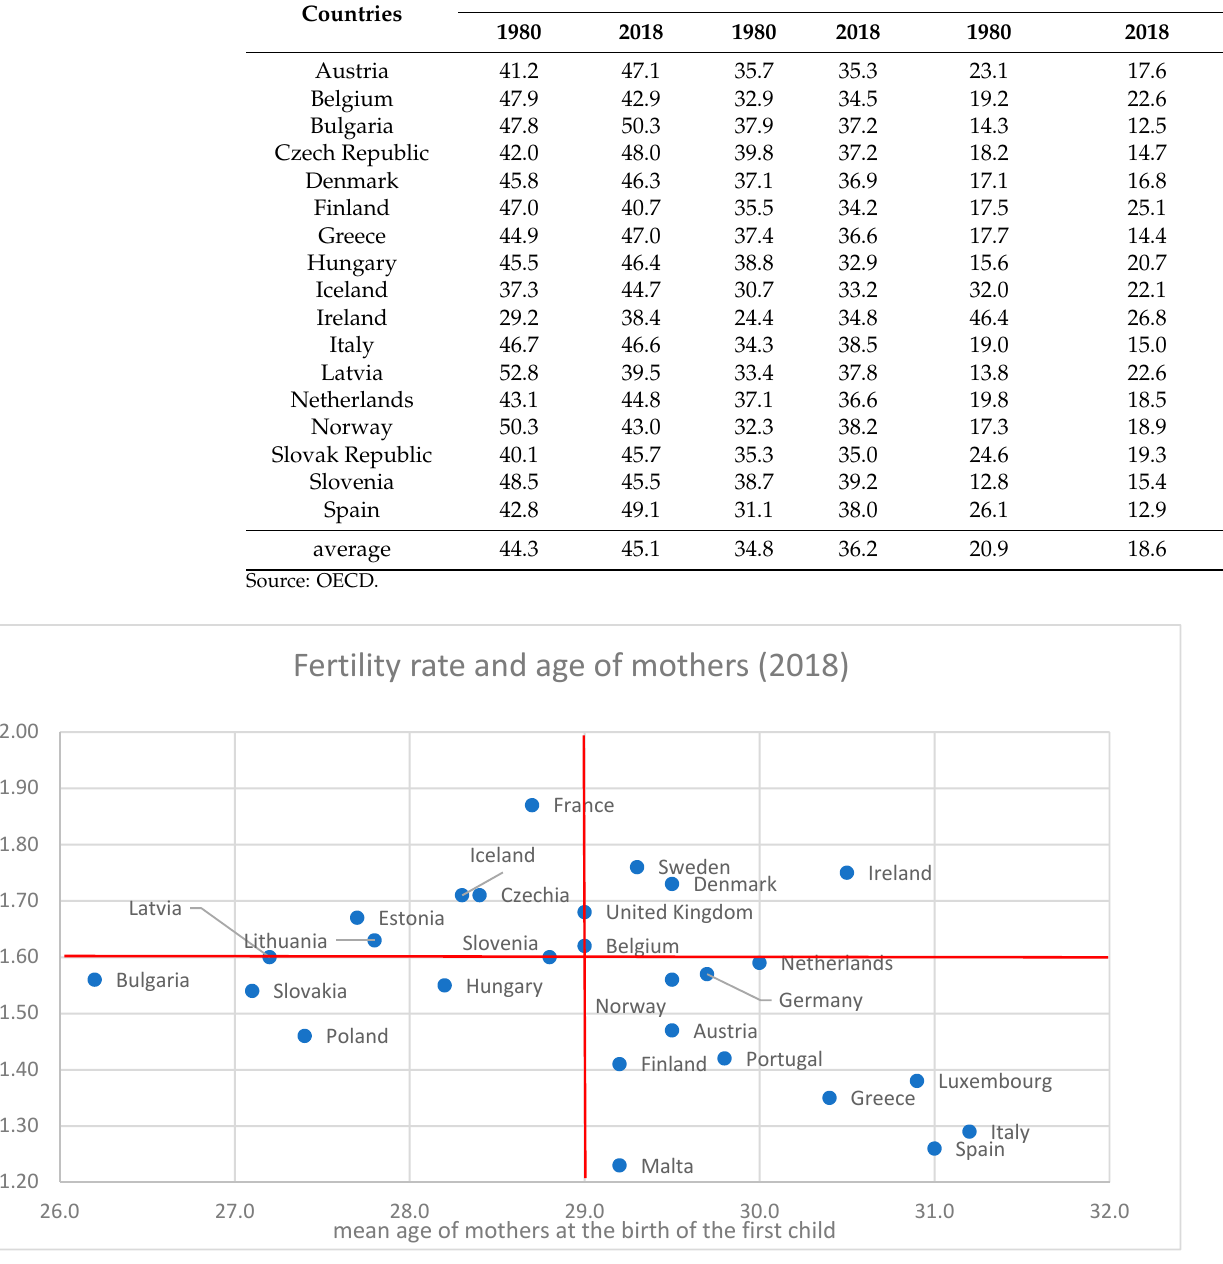
Figure 4. Source: our elaboration on Eurostat data.